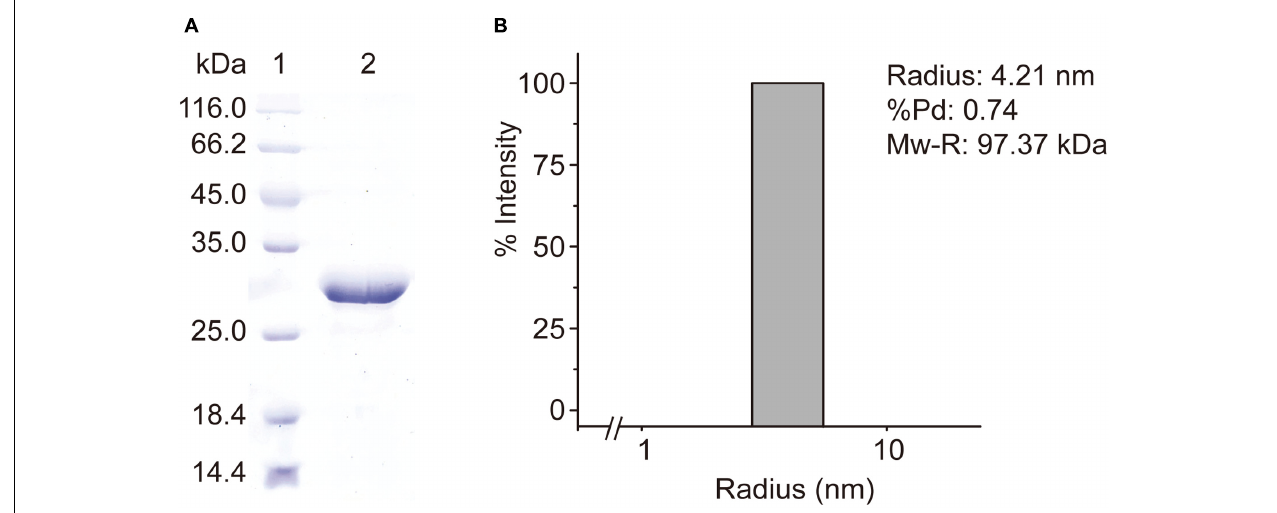
FIGURE 3 | Purification and characterization of Rd AcuH. (A) SDS-PAGE analysis of the purified Rd AcuH protein, showing an apparent MW of about 28 kDa. (B) DLS analysis of the molecular weight of Rd AcuH in solution. The %Pd is 0.74, indicating that it has high uniformity. The estimated molar mass is 97.37 kDa, indicating that it is a